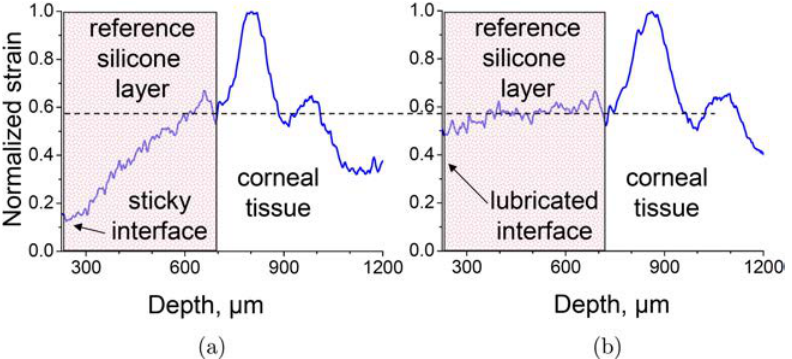
Fig. 2. Experimental examples of the stiction e®ect in the reference silicone layer overlaying softer tissue (excised rabbit eye cornea). (a) no lubrication added between the OCT probe and silicone, yielding very pronounced sticking and strain inhomogeneity in silicone; (b) same, but now with a small amount of lubricant (glycerol) added to the left interface. Interestingly that closer to the right silicone – cornea interface (at (cid:3) 700 (cid:4) m in the ¯gures) and in the tissue itself, the strain contrast pro¯les are similar for both stiction conditions (the same level of silicone strain near silicone – cornea interface is shown by the dashed line). In contrast, closer to the glass surface, the silicone is very di®erently deformed in plots (a) and (b).